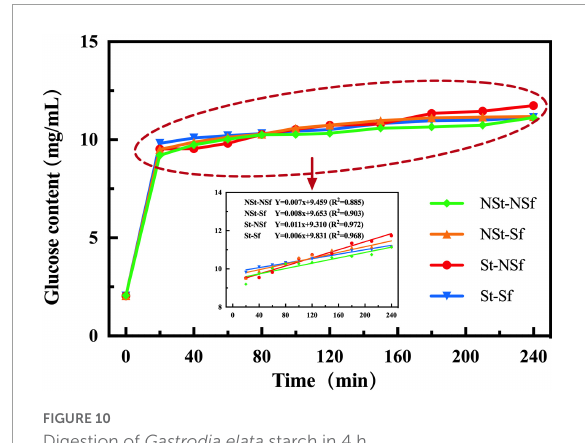
FIGURE10 Digestion of Gastrodia elata starch in 4